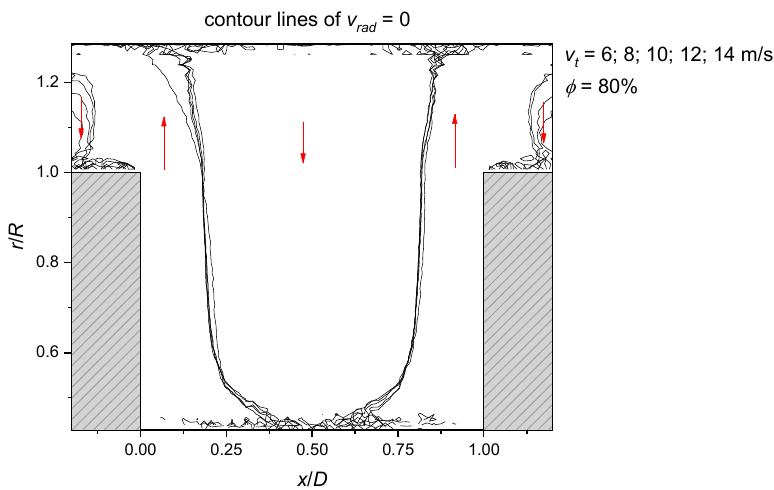
Figure 7. Contour lines of the radial velocity of zero for different circumferential speeds at a grinding media filling of 80%. The arrows show if the velocity was radially pointing outward or inward.